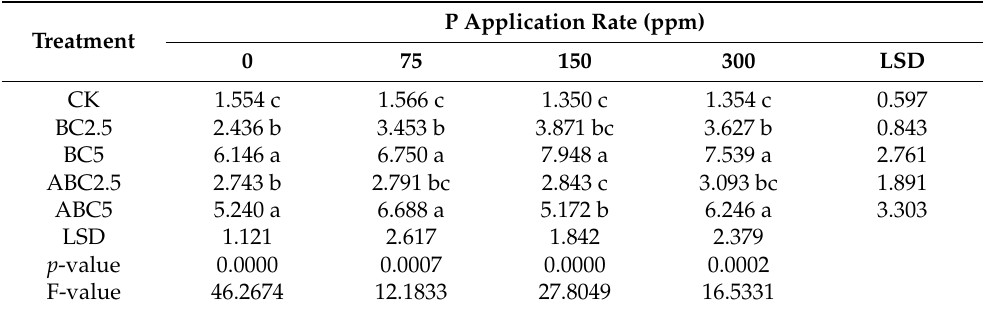
Table 7. Effects of BC and ABC applied at different rates with different P fertilizer application rates on soil OM in g kg − 1